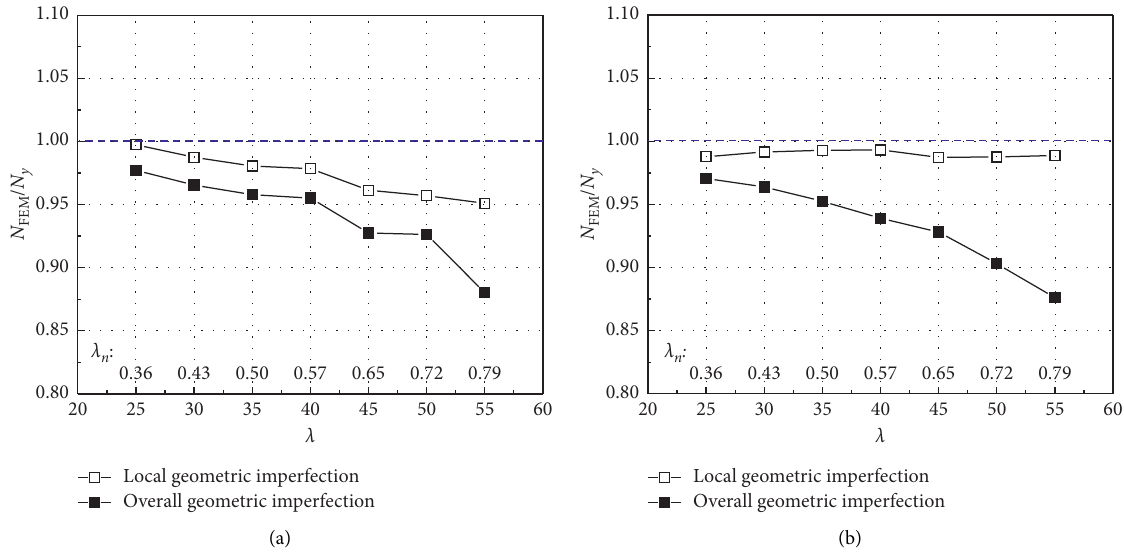
Figure 11: Comparison of geometric imperfection effect. (a) D159 × 6. (b) D508 × 8.